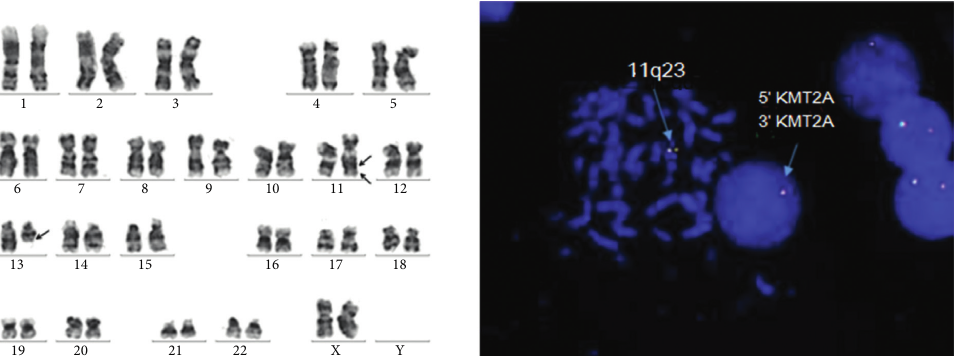
Figure 2: Karyotype: 46,XX,der (11) del (11) (q22 q23) ins (11; ?) (q22; ?), del(13) (q12q31) [50]. FISH (fluorescent in situ hybridization): nuc ish (KMT2A × 1) (5 ′ KMT2A con 3 ′ KMT2A × 1) [130/155], loss of 11q23.3 in 83% of cells.